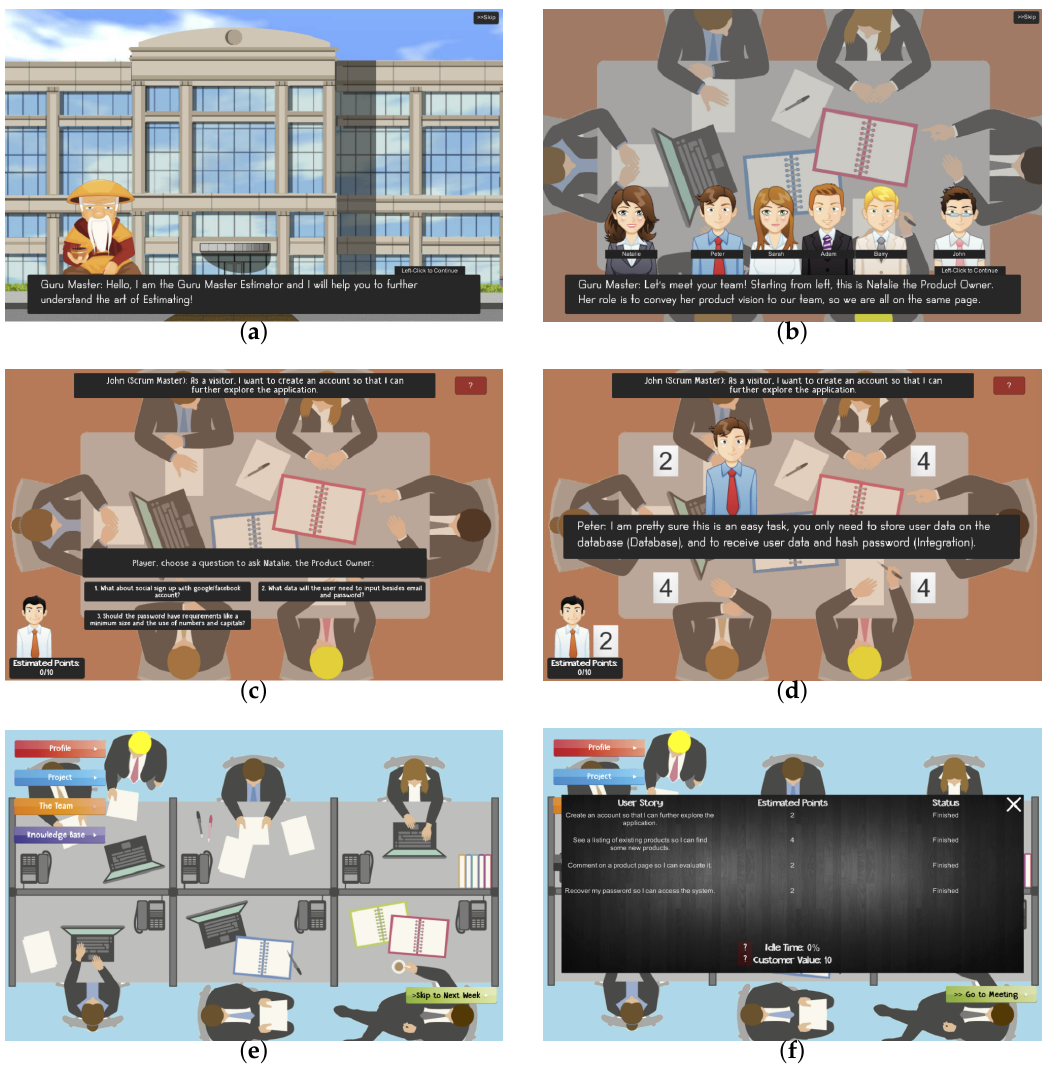
Figure 3. E4 Game screenshots. ( a ) Guru Master introducing the game. ( b ) Team being introduced at first planning meeting. ( c ) Player choosing which question to ask the Product Owner. ( d ) Team mates discussing why they chose their estimates. ( e ) Office screen. ( f ) Ending current sprint